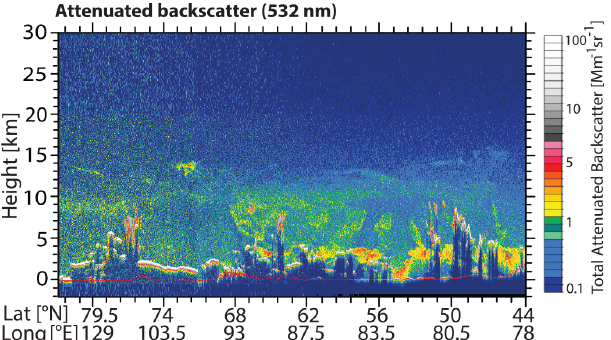
Figure 4. CALIPSO lidar measurement (height–latitude/longitude display of 532nm attenuated aerosol backscatter) of wildfire smoke over central and eastern Siberia on 26 July 2019, at 21:00UTC, dur- ing an overpass west of box 2, defined in Fig. 3, and downwind of large fires, according to Fig. 5. Thick smoke plumes (red, green, and yellow) reaching 10km height (tropopause level) were observed west of box 2 (55–68 ◦ N). Bluish layers above 10km height are very likely sulfate particle layers originating from the Raikoke vol- canic eruption.